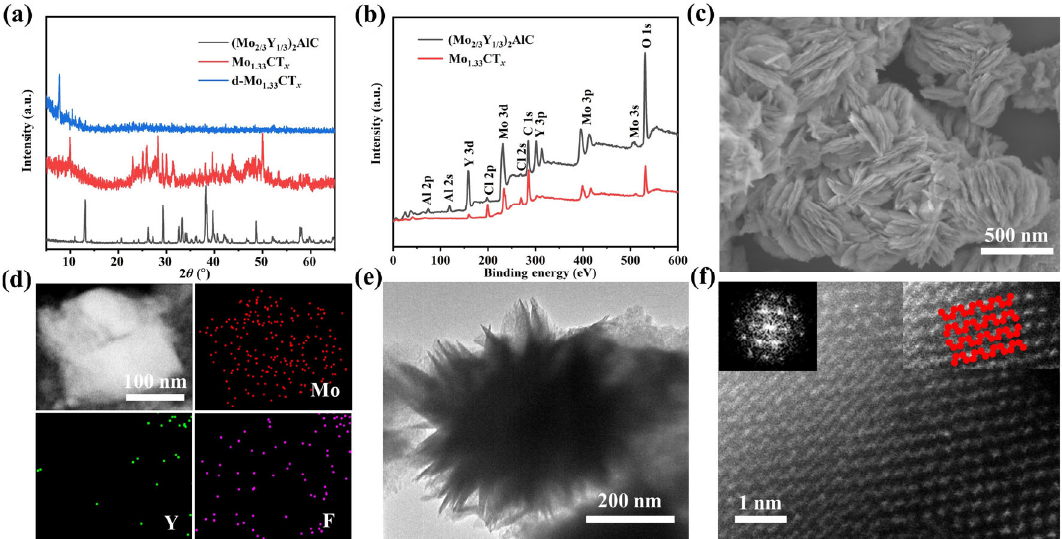
Figure 1 Synthesis of high-quality Mo 1.33 CT x i-MXene with ordered vacancies. (a) X-ray diffraction patterns of (Mo 2/3 Y 1/3 ) 2 AlC and Mo 1.33 CT x i-MXene. (b) XPS survey spectrum of (Mo 2/3 Y 1/3 ) 2 AlC and Mo 1.33 CT x i-MXene. (c) and (d) SEM and elemental-mapping images (Mo, Y, and F elements) of flower-like Mo 1.33 CT x , respectively. (e) and (f) TEM and STEM results of Mo 1.33 CT x ,